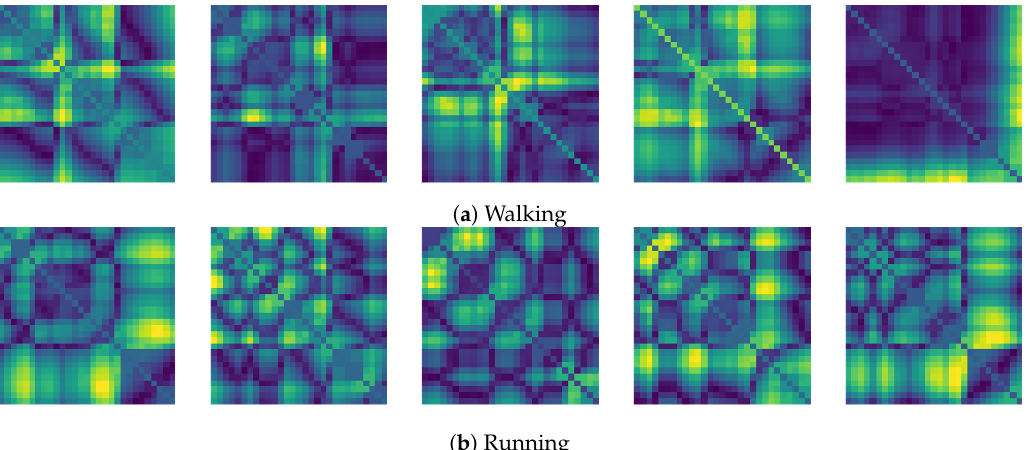
Figure 8. Recurrence plot samples for each motion from the gyro